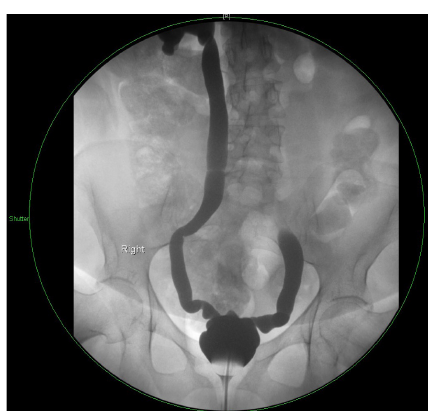
Figure 3. Retrograde pyelogram had previously demonstrated a small urinary bladder capacity and grossly dilated